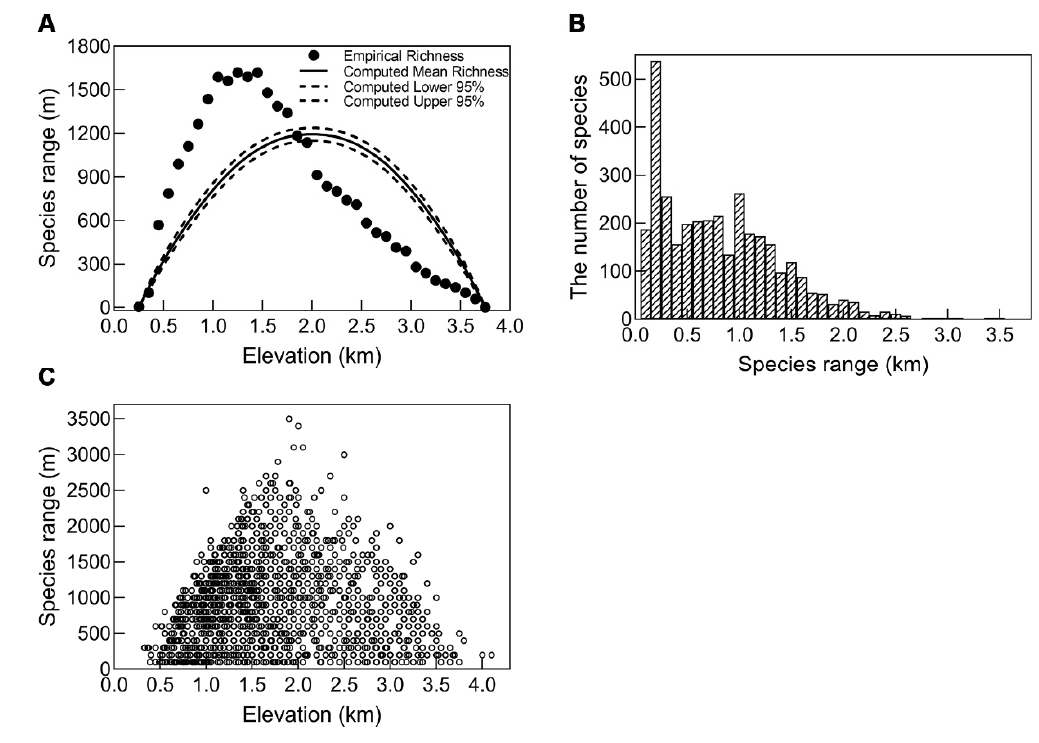
Figure 4. ( A ) The patterns between predicted species richness and actual species richness with elevation by range model. ( B ) Variation in the number of species in different species range. ( C ) The patterns of species range with elevation.